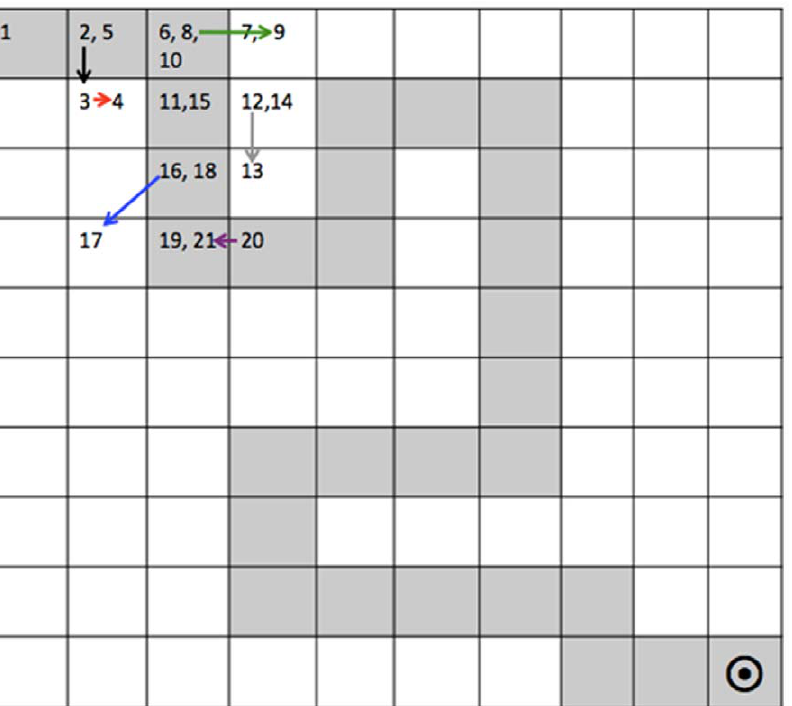
Figure 1. The Groton Maze Learning Test: Stimulus and Examples of Error Types. Tiles shaded in gray represent one of the hidden maze pathways on the GMLT; numbers indicate order of moves for a sample participant; Move 2 to 3 (shown in black): exploratory error; Move 3 to 4 (shown in red): rule-break error (tapping on same tile twice); Move 8 to 9 (shown in green): perseverative error; Move 12 to 13 (shown in grey): rule break error (not moving back to the last correct tile); Move 16 to 17 (shown in blue): rule break error (no moving diagonally); Move 20 to 21 (shown in purple): rule break error (moving backwards along the maze).